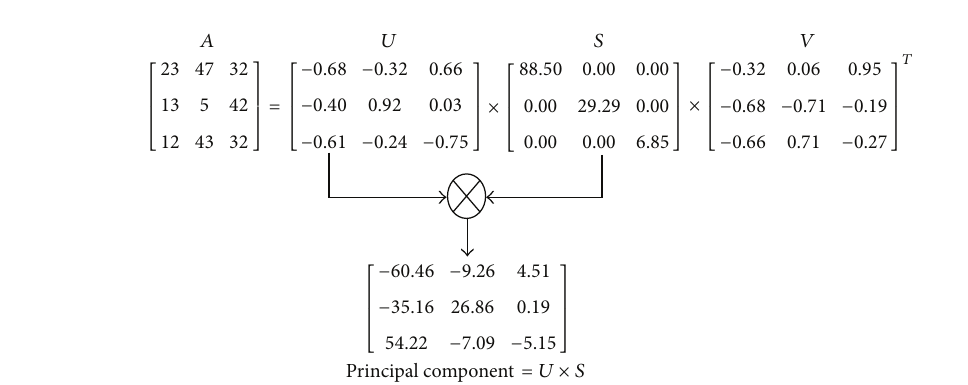
image are invariant under the operation of rotation and